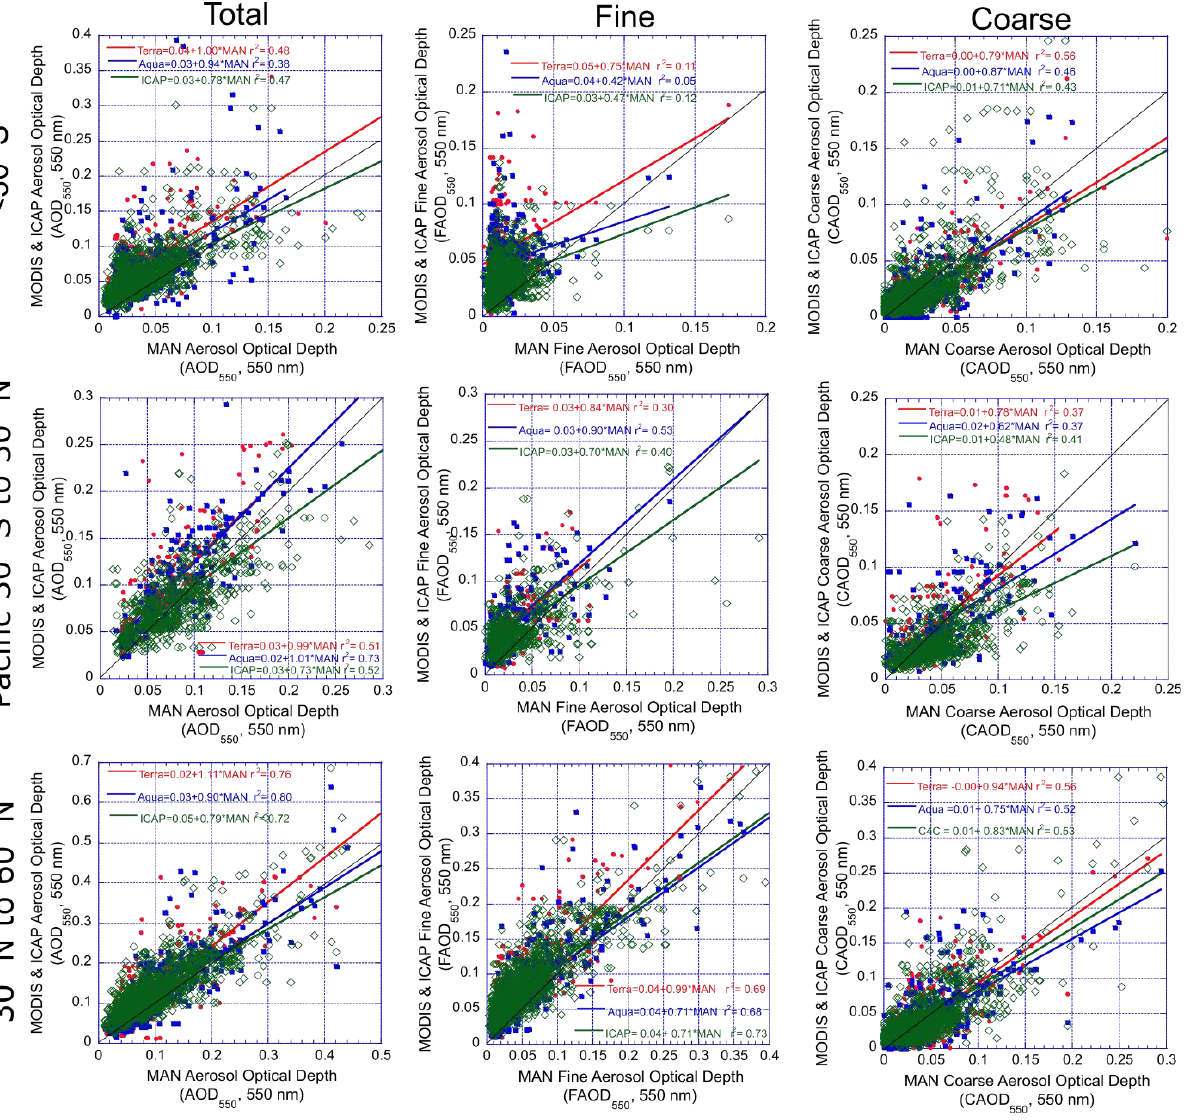
Figure 15. Scatter plots of total AOD (AOD 550 ), fine mode AOD (FAOD 550 ), and coarse mode AOD (CAOD 550 ) for three remote regions: Top row southern oceans (South of 30°S); middle row subtropical to tropical Pacific (30°S to 30°N); and bottom row northern hemisphere mid-latitudes (>30°N).